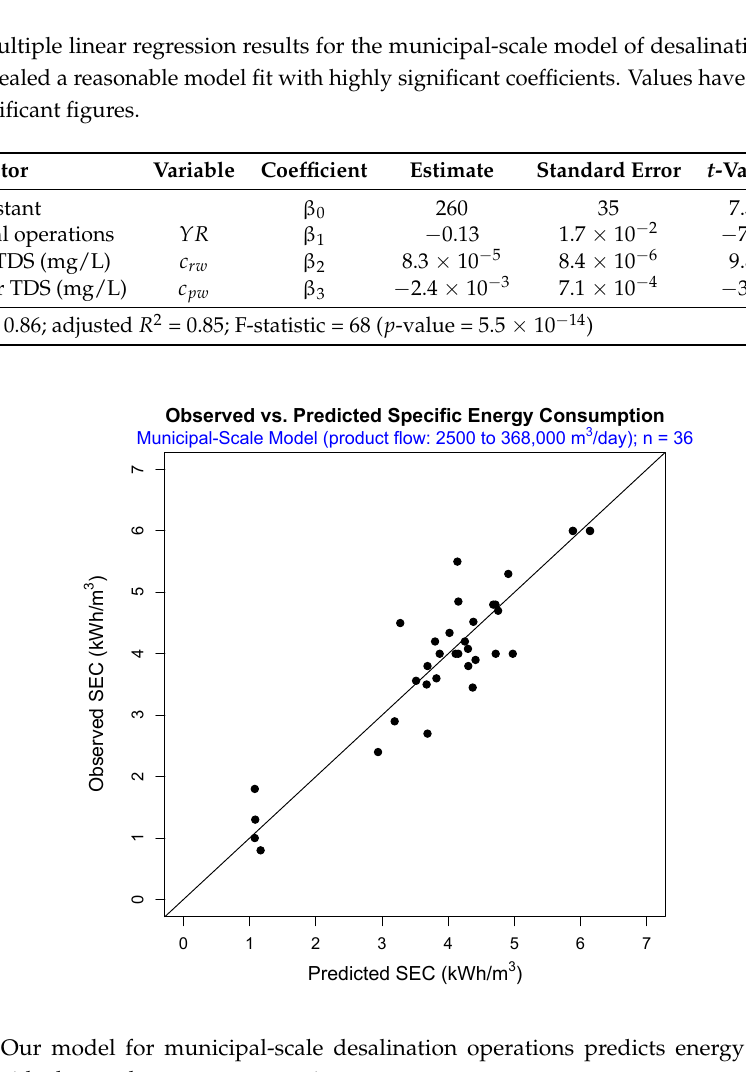
Figure 2. Our model for municipal-scale desalination operations predicts energy consumption consistent with observed energy